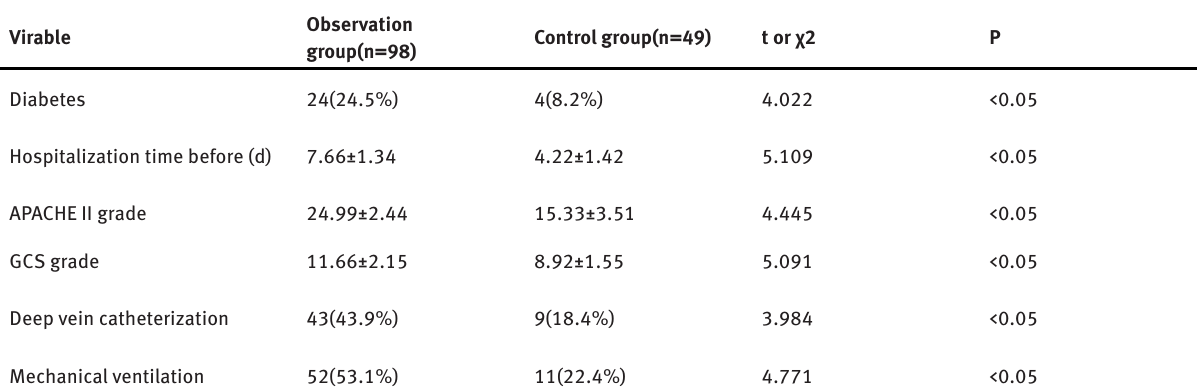
Table 2: Univariate analysis of pan-resistant Acinetobacter baumannii infection in ICU pneumonia patients